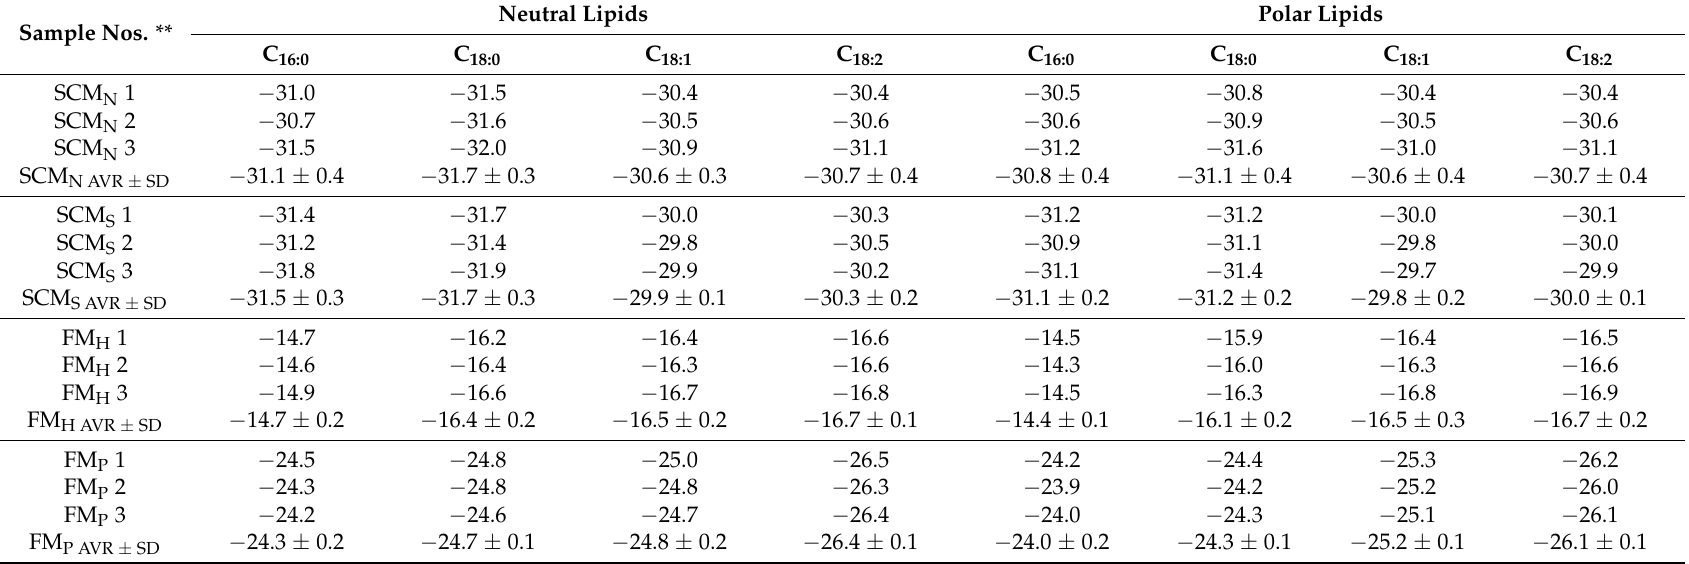
Table 3. δ 13 C values ( ‰ ) of individual major fatty acids in neutral and polar lipids from O. sinensis substitutes * .